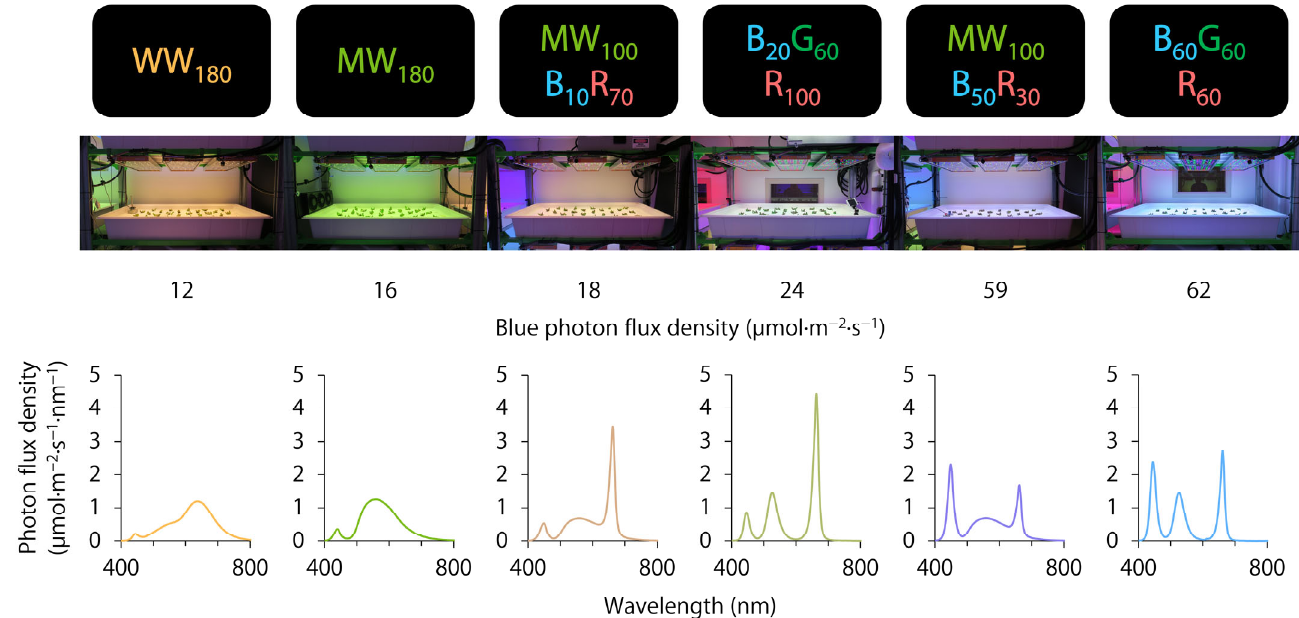
Figure 4. Photos and spectral distributions of six indoor lighting treatments delivered by warm-white (WW), mint-white (MW), blue (B), green (G), and/or red (R) light-emitting diodes (LEDs). The number after each LED type is its photon flux density in μ mol·m − 2 ·s − 1 .